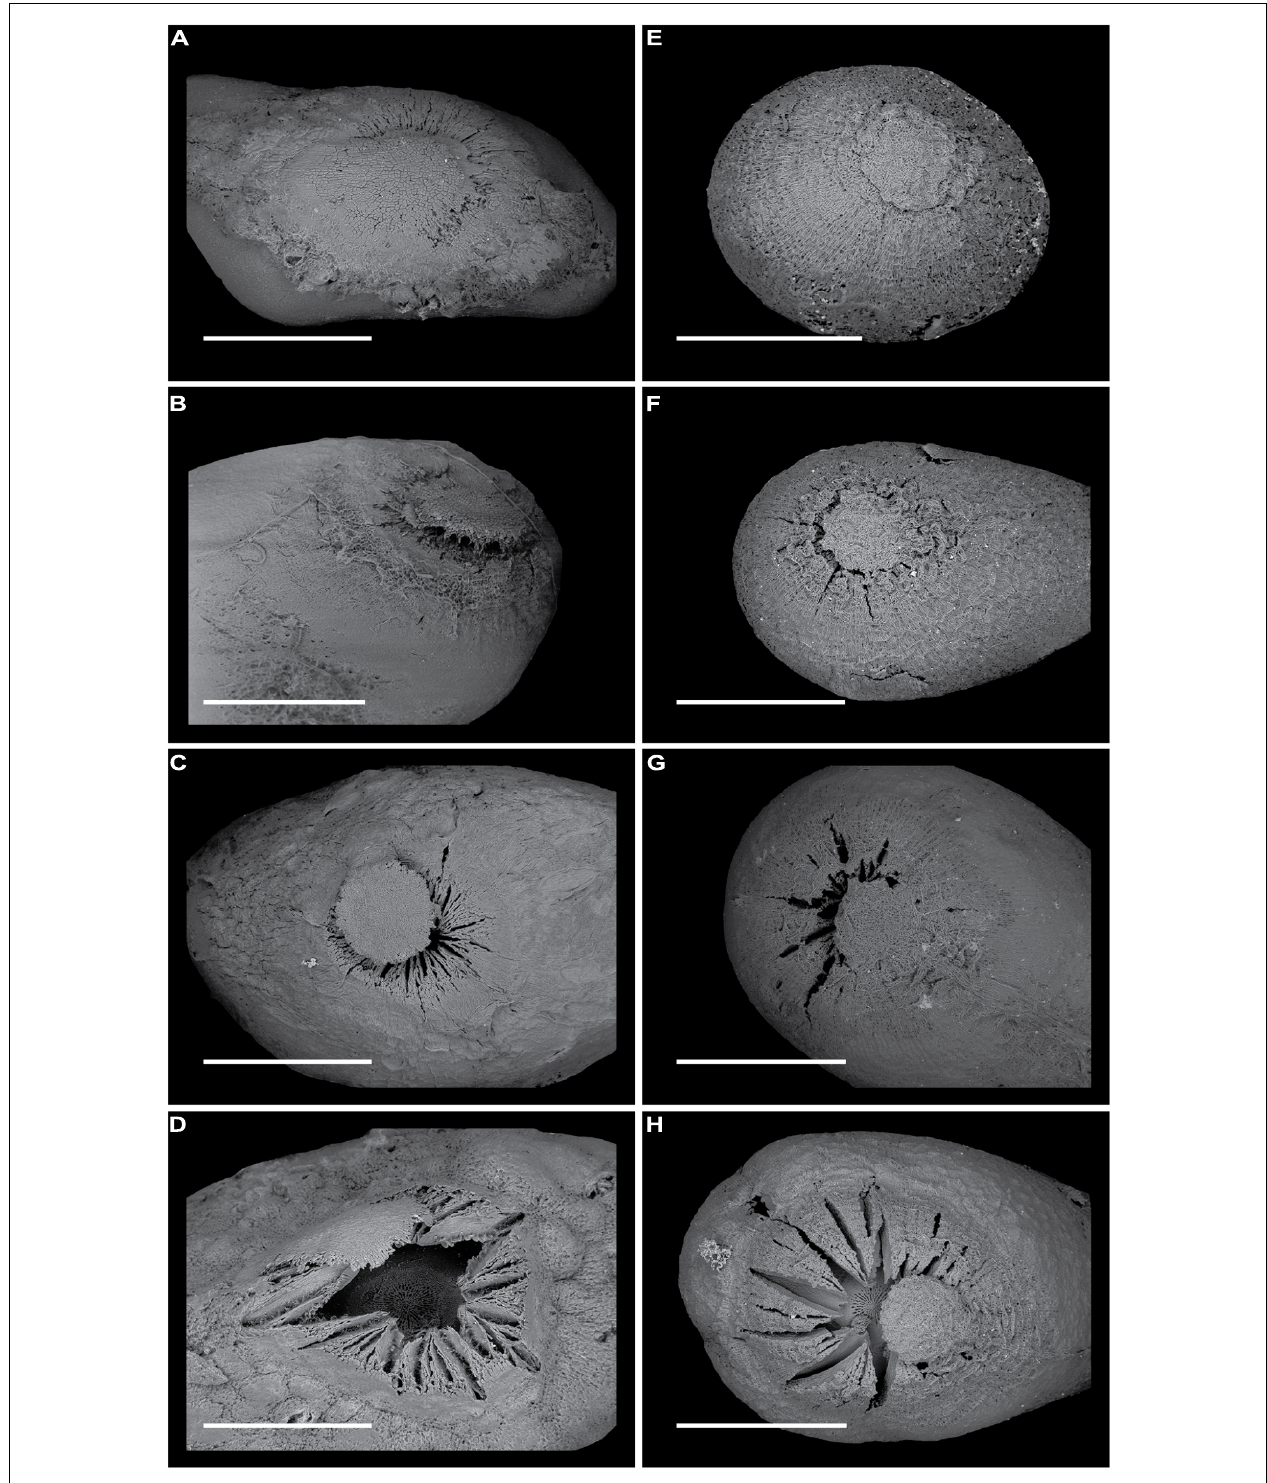
FIGURE 7 | Scanning electron microscopy images revealing the time course of chalazal plug breakage over 5 days for Apeiba seeds (A–D) and Ochroma seeds (E–H). At the onset of the experiment, seeds of Apeiba (A) and Ochroma (E) previously determined as impermeable had no evidence of